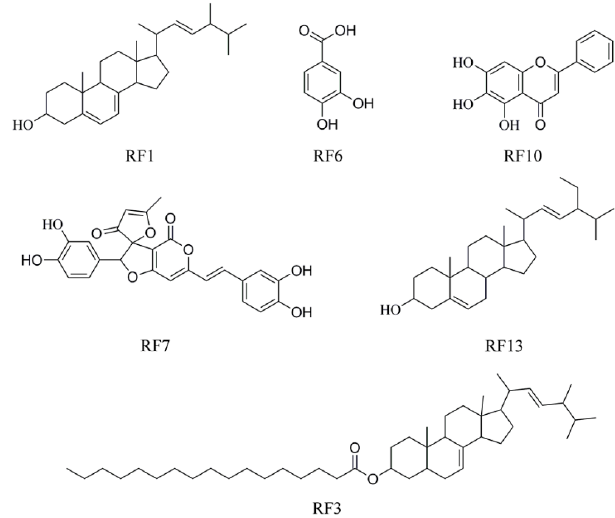
Figure 3. Chemical structures of compounds RF1, RF3, RF6, RF7, RF10, and RF13 isolated from P. baumii mycelium produced by solid-state fermentation in